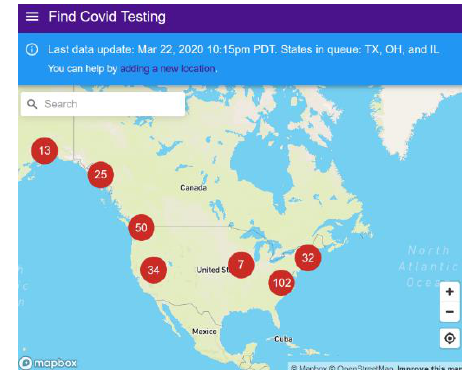
Figure 7. Volunteers developed the ‘Find Covid Testing’